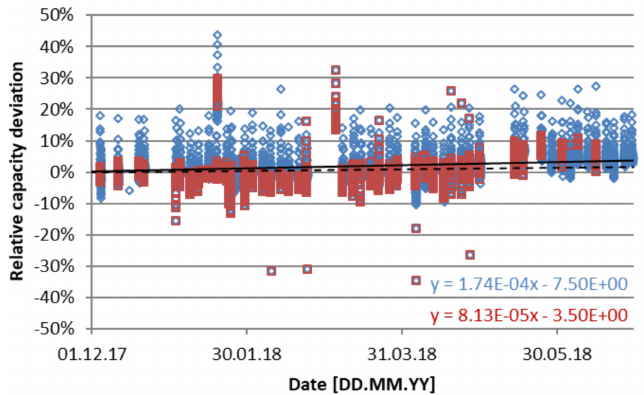
Figure 6. Trend of relative decrease of cooling tower power (calculated minus measures divided by measured) during the operation with water-glycol (data set Lab-Scal1a); model was calibrated with data recorded in the first week of December); blue dots: all fan speeds; red dots: only 100% fan speed; black lines: linear regression (solid: all fan speeds, dashed: only 100% fan speed).